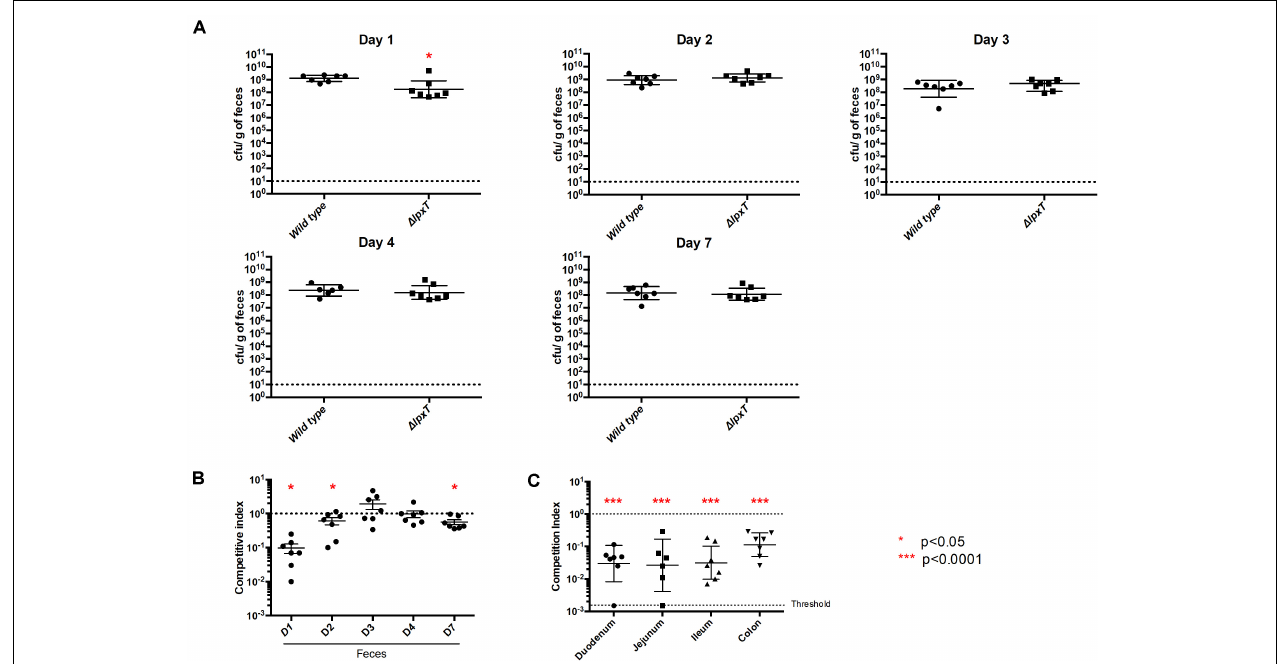
FIGURE 13 | LpxT inactivation impairs colonization of mice. Groups of 7 OF1 mice were infected by gavage by MG1655 and MG lpxT (Cm R ) strains (2 × 10 8 bacteria per mouse) either separately (A) or as a mixture of both bacterial strains in equal proportions (B,C) . (A) Colonization rates were determined after 1, 2, 3, 4, and 7 days post-infection by enumeration of CFU per gram of gut. (B) Colonization rates were determined by the enumeration of CFU within the feces on LB-agar plates supplemented or not with chloramphenicol, after 1, 2, 3, 4, and 7 days post-infection. The results were expressed as the ratio of Cm R bacteria out of the total recovered bacteria (competitive index). (C) Competitive index were determined by enumeration of bacteria (total and Cm R ) in different regions of the gut after 1 day post-infection. Circles and squares represent individual mice while mean colonization levels are illustrated by horizontal bars. As indicated by red asterisks (* p < 0.05; *** p < 0.0001), the lpxT mutant showed a statistically significant defect in colonization when compared to the wild type strain in both separate and co-infection experiments. Data from two independent cohorts of mice were combined to increase significance and robustness of the